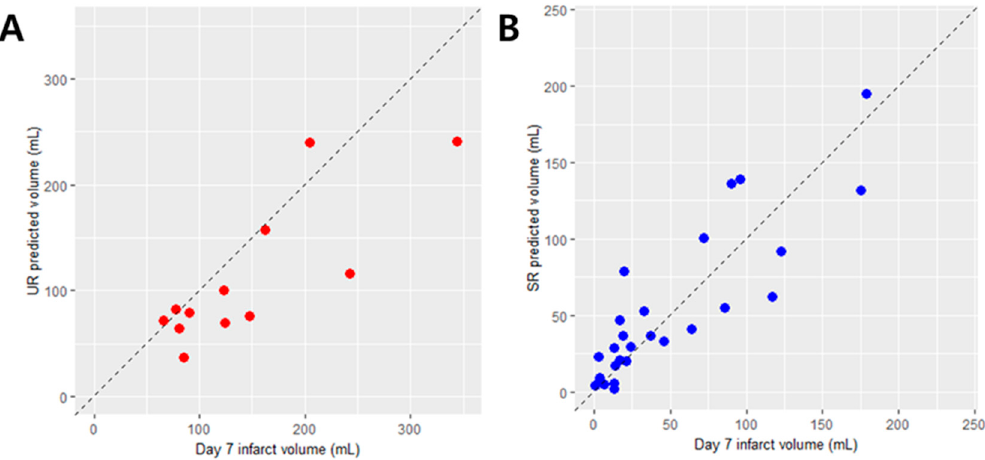
Figure 3. Correlation plots of ( A ) the UR-predicted infarct volume and ( B ) the SR-predicted infarct volume on the external validation UR and SR cohorts, respectively. The manual infarct volume measurement on day-7 DWI served as the reference.